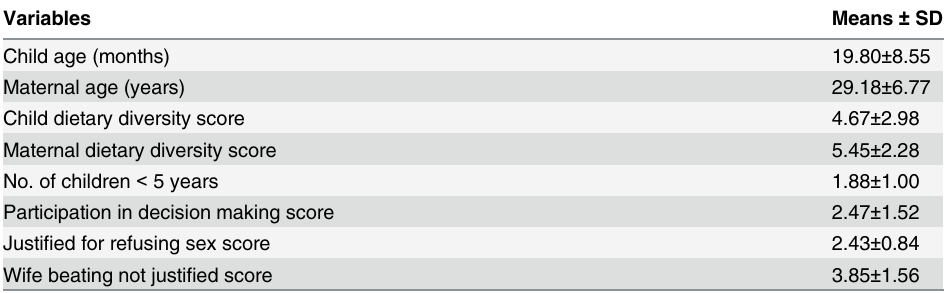
Table 1. Selected characteristics of the study sample (n = 1187), continuous variables, means and standard deviations